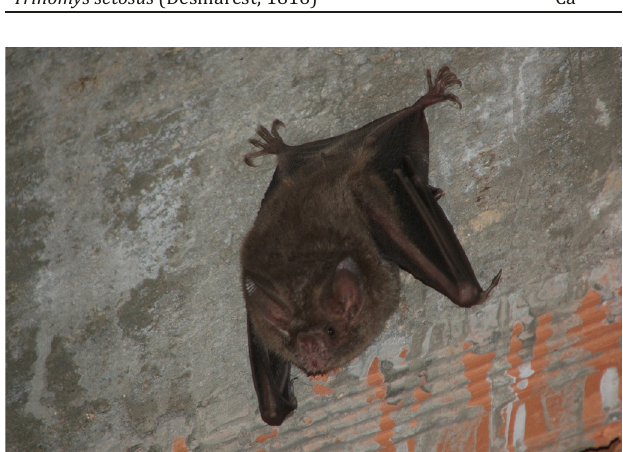
Trachops cirrhosus in